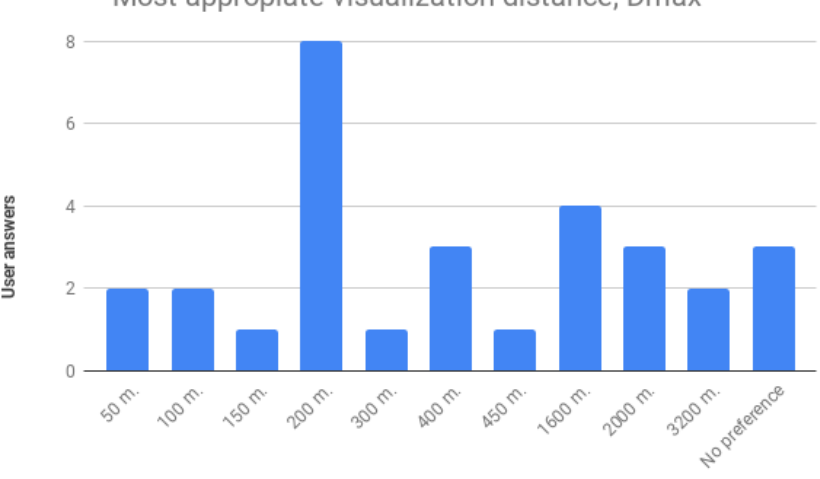
Figure 16. Distribution of preferred D max